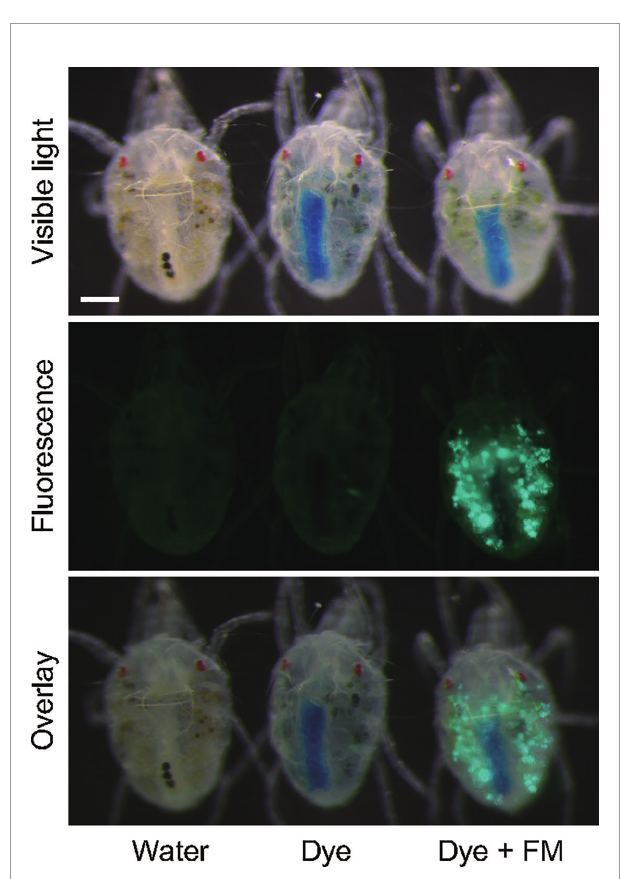
FIGURE 5 | Oral delivery of fl uorescent nanoparticles (diameter, 500 nm) to adult Tetranychus urticae females with the mesh method. Mites were allowed to ingest at 25°C for 24 h. In the control, water or 1% (w/v) blue tracer dye (Brilliant Blue FCF) solution was placed in the feeding